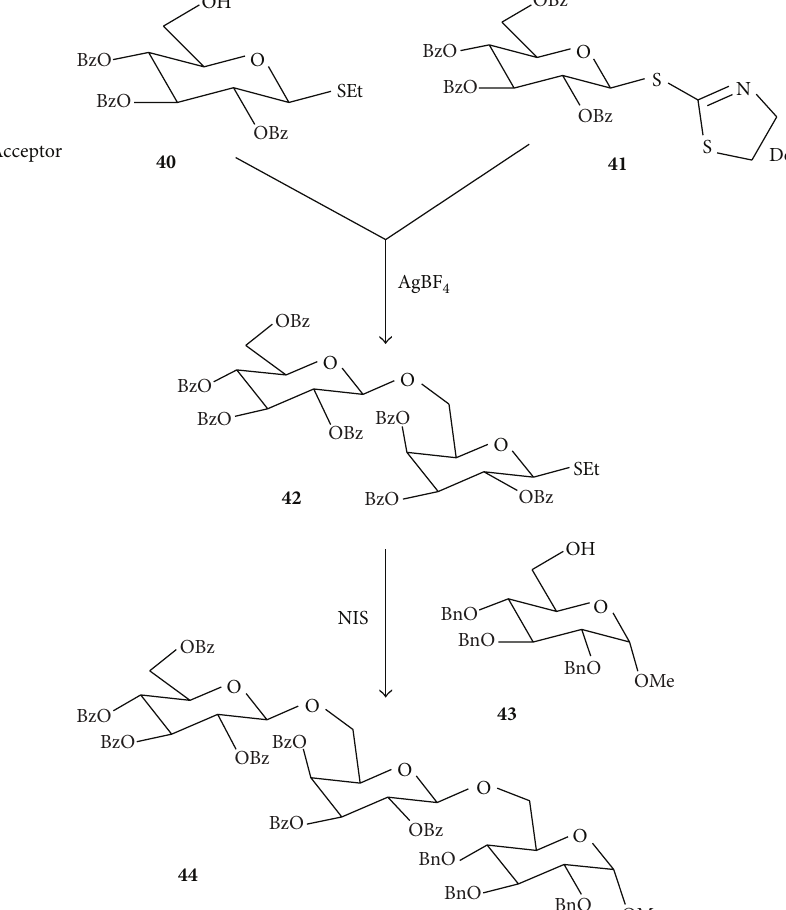
Scheme 6: AgBF 4 as a potent promoter for chemical